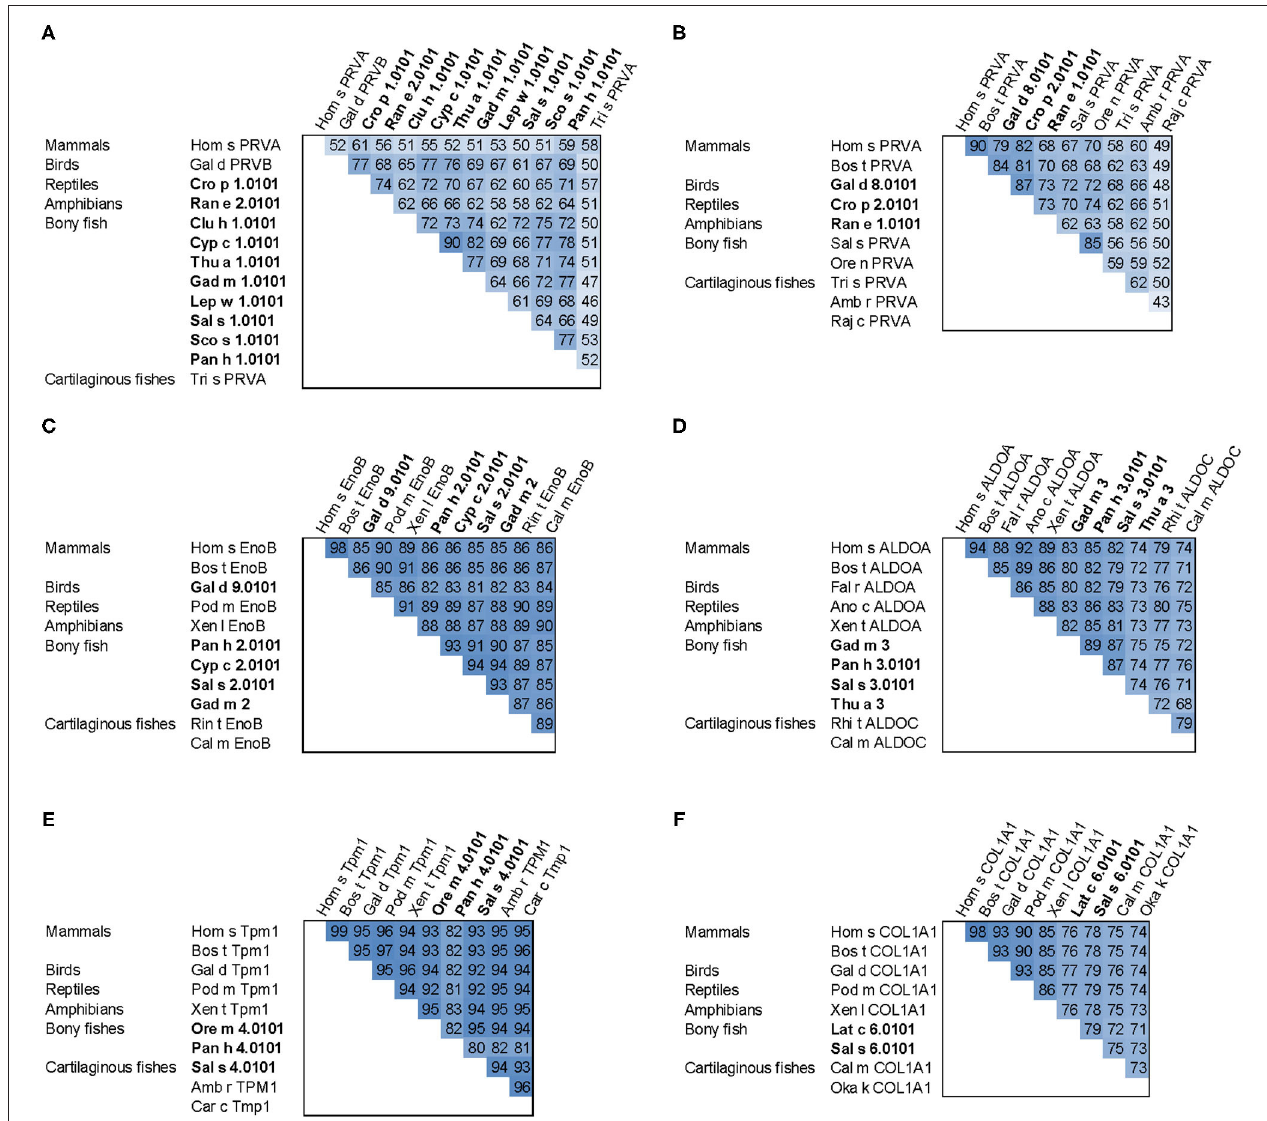
FIGURE 4 | Sequence comparison of fish allergens with homologs from other vertebrates. (A) β -parvalbumins compared with human and cartilaginous fish α -parvalbumins; (B) α -parvalbumins; (C) β -enolase; (D) aldolase A compared with cartilaginous fish aldolase C; (E) tropomyosin α 1; (F) collagen type I α 1 chain. Allergens are printed in bold; the numbers show percent sequence identities between pairs of proteins extracted from multiple sequence alignments generated using ClustalX (37). Species abbreviations: Amb r, Amblyraja radiata (thorny skate); Ano c, Anolis carolinensis (American chameleon); Bos t, Bos taurus (cattle); Cal m, Callorhinchus milii (elephant shark); Car c, Carcharodon carcharias (great white shark); Clu h, Clupea harengus (Atlantic herring); Cro p, Crocodylus porosus (Australian saltwater crocodile); Cyp c, Cyprinus carpio (Common carp); Fal r, Falco rusticolus (gyrfalcon); Gad m, Gadus morhua (Atlantic cod); Gal d, Gallus domesticus (chicken); Hom s, Homo sapiens (human); Lat c, Lates calcarifer (barramundi perch); Lep w, Lepidorhombus whiffiagonis (megrim); Oka k, Okamejei kenojei (ocellate spot skate); Ore m, Oreochromis mossambicus (Mozambique tilapia); Ore n, Oreochromis niloticus (Nile tilapia); Pan h, Pangasianodon hypophthalmus (striped catfish); Pod m, Podarcis muralis (common wall lizard); Raj c, Raja clavata (thornback ray); Ran e, Pelophylax lessonae (Pool frog); Rhi t, Rhincodon typus (whale shark); Sal s, Salmo salar (Atlantic salmon); Sco s, Scomber scombrus (Atlantic mackerel); Thu a, Thunnus albacares (yellowfin tuna); Tri s, Triakis semifasciata (Leopard shark); Xen l, Xenopus laevis (African clawed frog); Xen t, Xenopus tropicalis (tropical clawed frog). show low allergenicity, most likely as a consequence of their high sequence identities with human homologs ( Figure 4E )